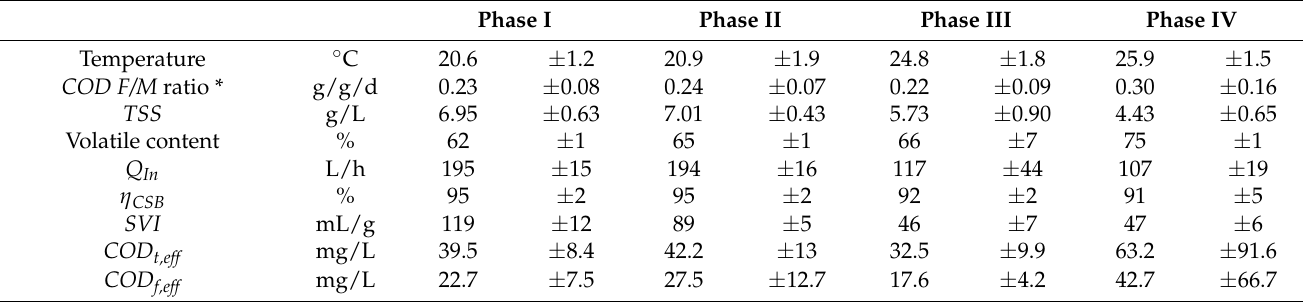
Table 4. Operating parameters of the pilot plant for individual test Phases I to IV.